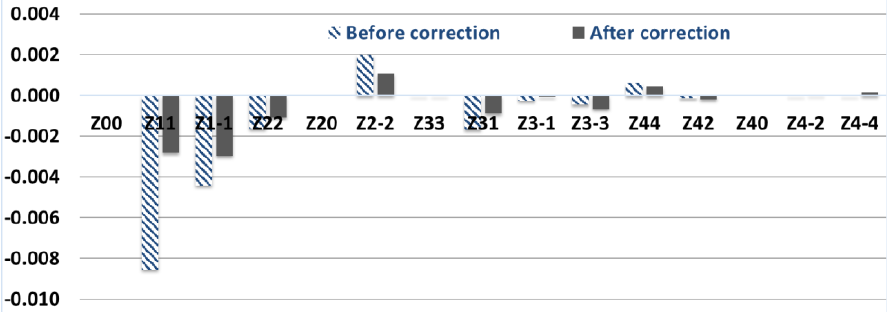
Figure 6. Zernike polynomial weight values for total wave aberration before and after correction taking into account intraocular compensation (Zernike basis functions other than ( n , 0)).